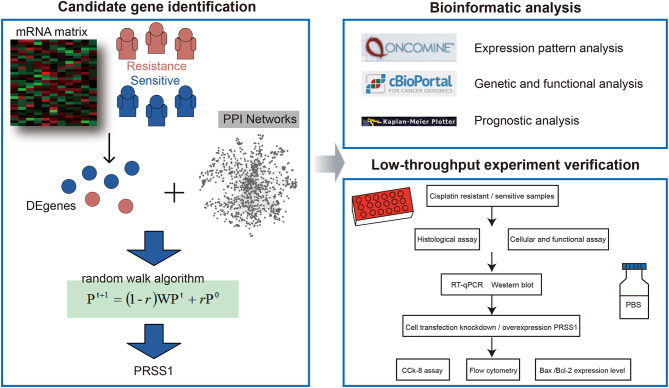
Overall workflow.